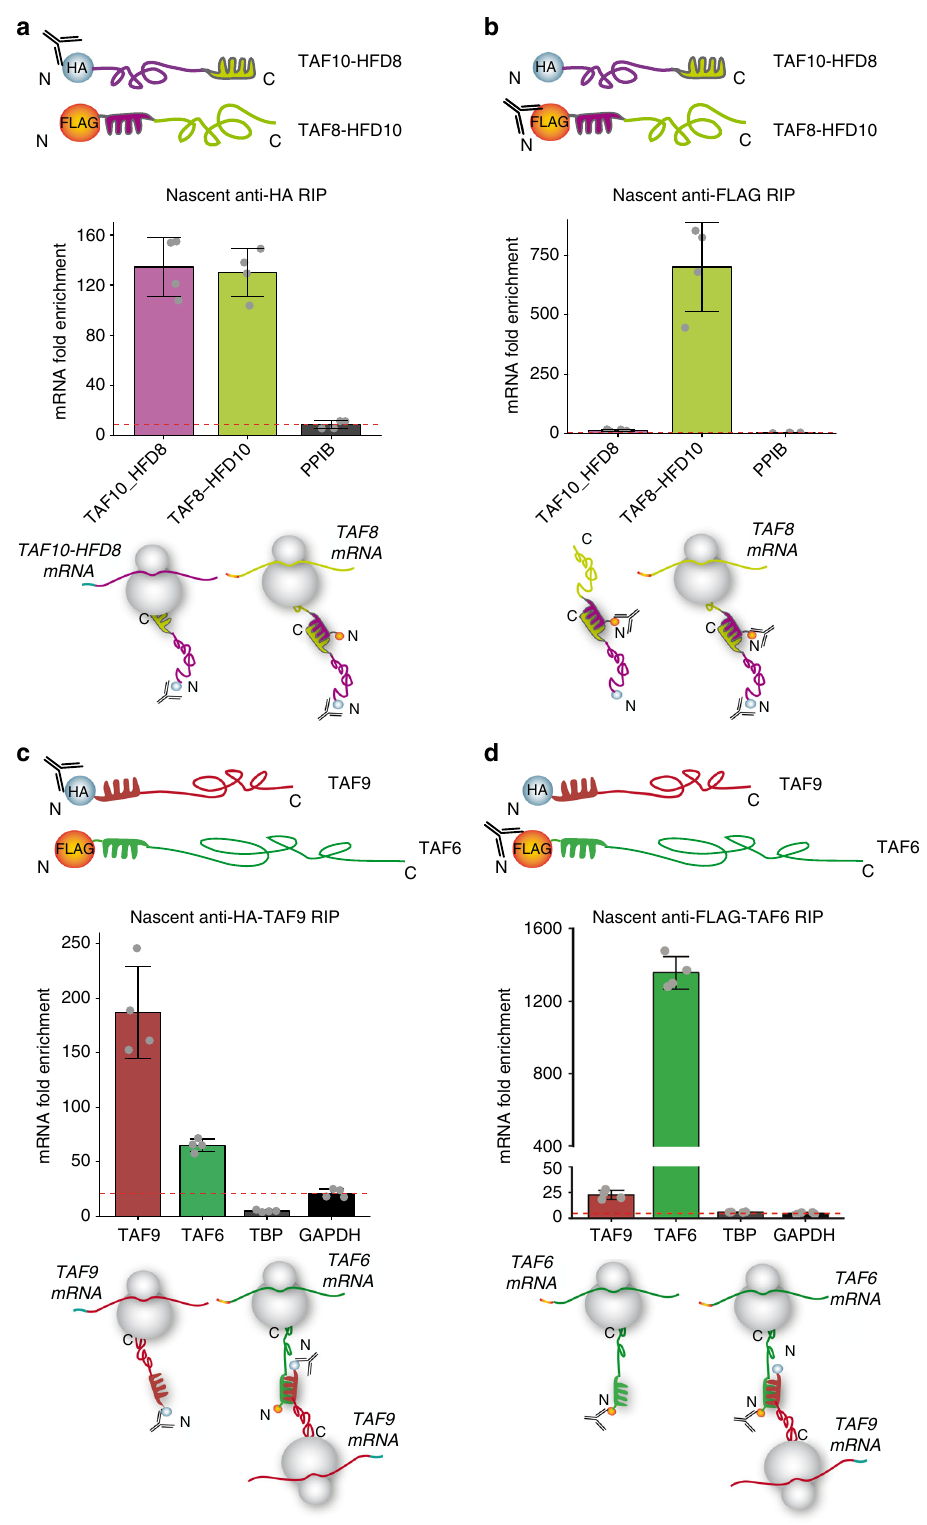
Fig. 6 ID position determines the order of co-translational assembly. RIP-qPCR of HFD domain-swapped TAF10 and TAF8 expression constructs using anti- HA ( a ) or anti-FLAG ( b ) antibodies against the respective N-terminal tags. c , d RIP-qPCR of anti- HA-TAF9 IP ( c ) and anti-FLAG-TAF6 IP ( d ) from HeLa cell polysome extracts co-transfected with TAF9 and TAF6 expression constructs as indicated. PPIB ( a , b ) and GAPDH ( c , d ) were used as negative control mRNAs. In all the graphs error bars represent ±SD from two biological replicates and two technical replicates (represented by grey dots). Source data provided as a Source Data